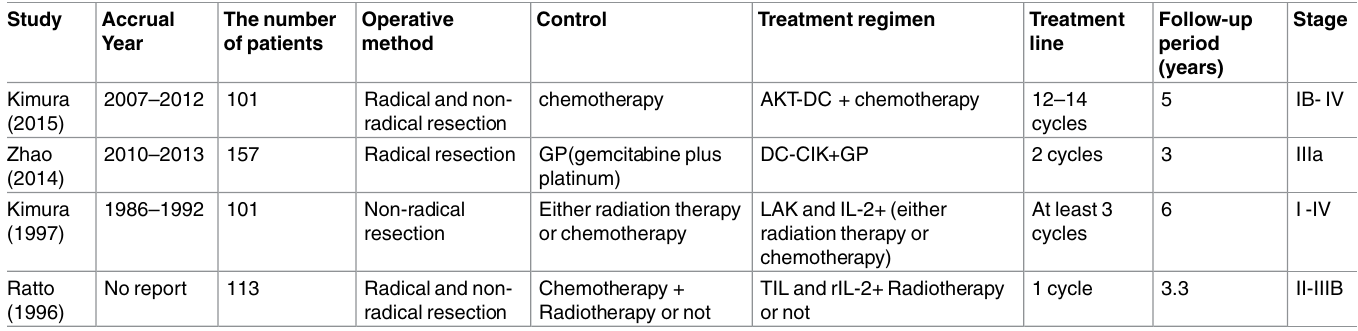
Table 1. Characteristics of Included Studiesfor